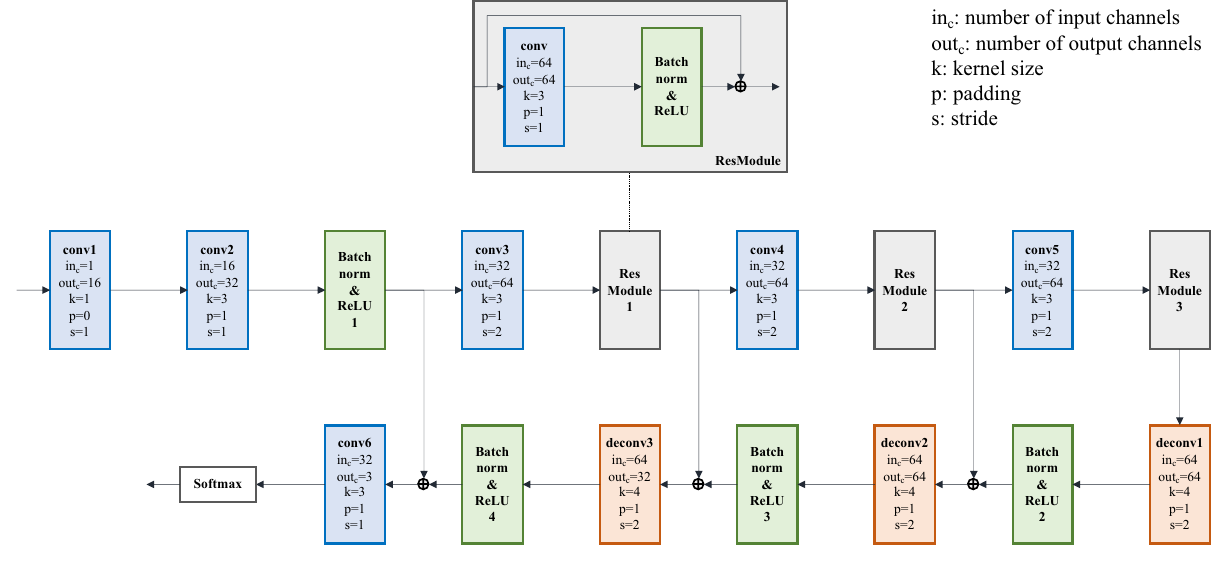
Figure 4. The structure of 3DCellSegNet. [Note: The extra voxels on the edge of the feature maps are removed after each deconvolution operation, in order to ensure the size of the up-sampled feature map is identical with that of the corresponding down-sampled feature map].